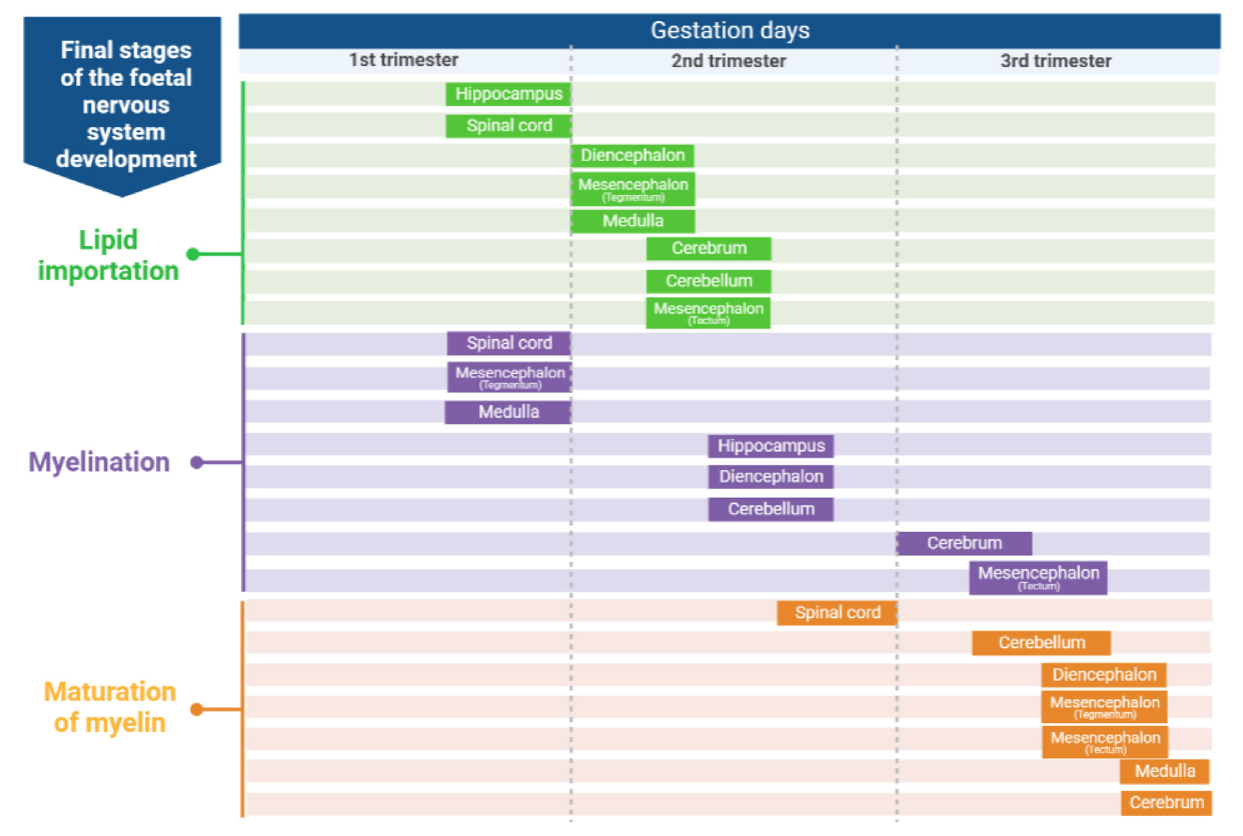
FIGURE1 Developmental stages (lipid importation, myelinization and maturation of myelin) of the fetal lamb nervous system [adapted from Barlow (29)]. Created with